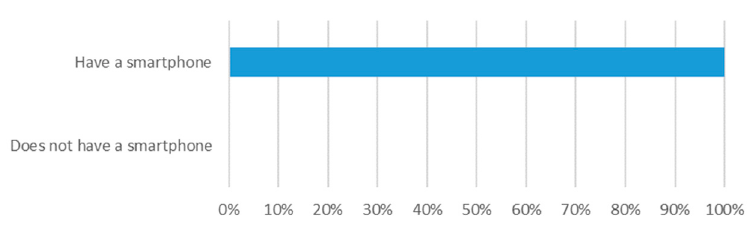
Figure 2. Responses to smartphone ownership question.